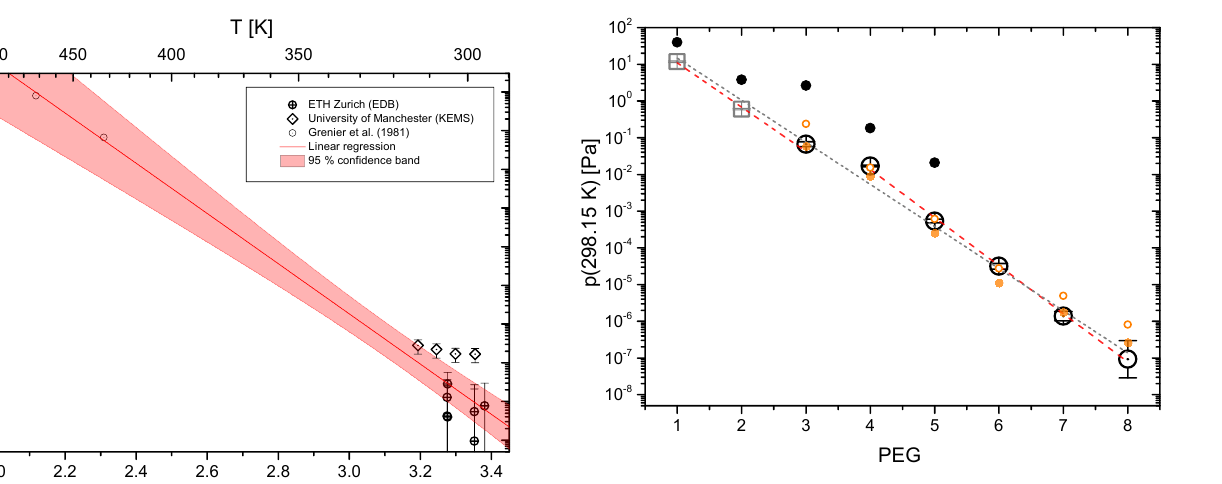
Figure 8. Saturation vapor pressure at 298.15K plotted for all PEGs. Open black circles with error bars: results of this study. Filled orange circles: extrapolation of high-temperature literature data to 298.15K using an estimation of the temperature dependence of the enthalpy of evaporation as detailed in Appendix B. Open orange cir- cles: extrapolation of high-temperature literature data to 298.15K assuming a constant enthalpy of evaporation. Filled black circles: computational predictions from this study. Open squares with error bars: Ambrose and Hall (1981). Dashed gray line is a linear regres- sion to all the experimental data; dashed red lines are separate linear regressions for n = 1 to n = 3 and n = 4 to n =